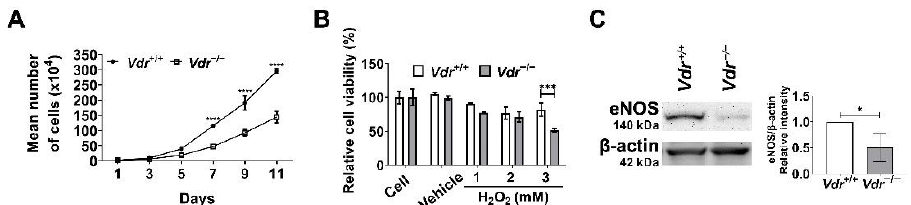
Figure 7. Upregulated activities of pro-inflammatory transcription factors in Vdr −/− retinal EC. ( A ) phosphorylated NF- κB (p-p65) and NF- κB (p65) levels in Vdr +/+ and Vdr −/− retinal EC were determined by Western blot analysis with specific antibodies. (n = 4, * p < 0.05) ( B ) Indirect immunofluorescent staining of p65 (green), p-p65 (red), and nuclei (blue) was performed to demonstrate localization of NF- κB. ( C ) Phosphorylated STAT1 and STAT1 levels in Vdr +/+ and Vdr −/− retinal EC were determined by Western blot analysis with specific antibodies (n = 4, * p < 0.05).